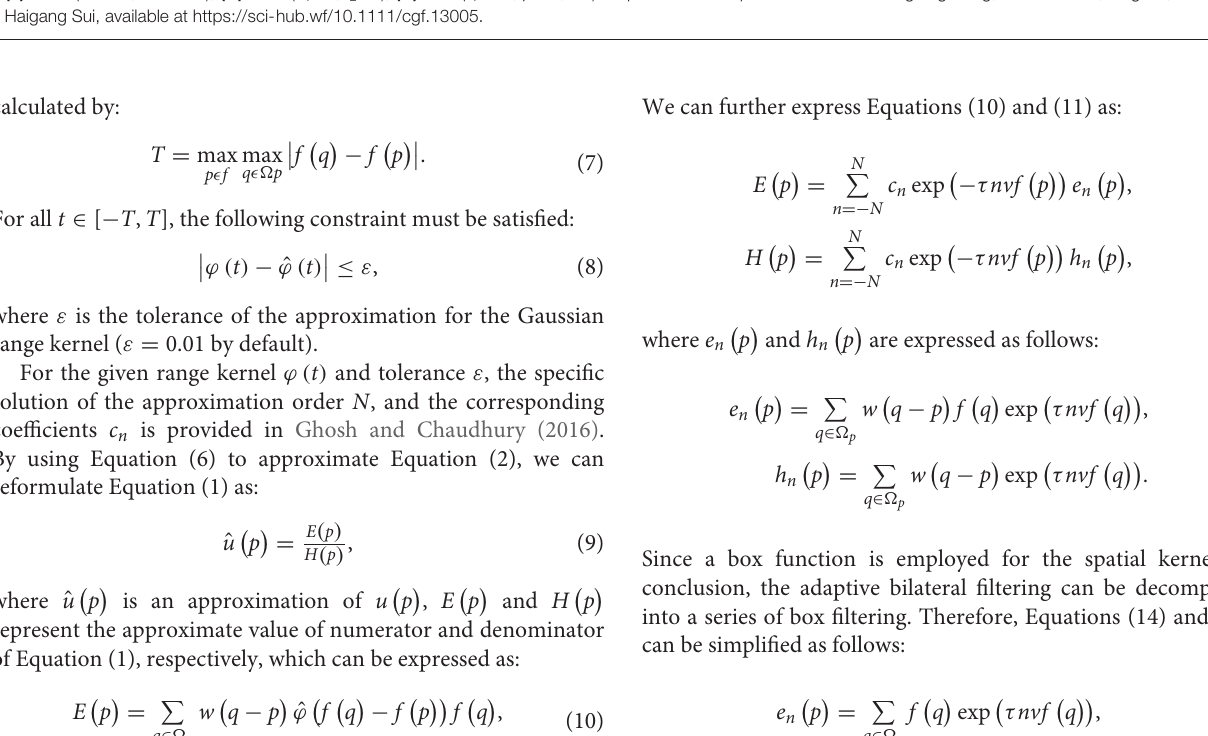
FIGURE 4 | Visual effect comparison of texture filtering results. (A) Input image; (B) RTV ( λ = 0.015, σ = 6); (C) SGTD ( mu = 0.31); (D) RGF ( σ s = 5, σ r = 1); (E) BTF ( k = 9); (F) SATF ( sr = 0.1, se = 0.05); (G) ROG ( σ 1 = 1, σ 2 = 3); (H) ours ( σ r = 35, η = 10, I = 2). Reproduced with permission from Chengfang Song, Chunxia Xiao, Ling Lei, and Haigang Sui, available at